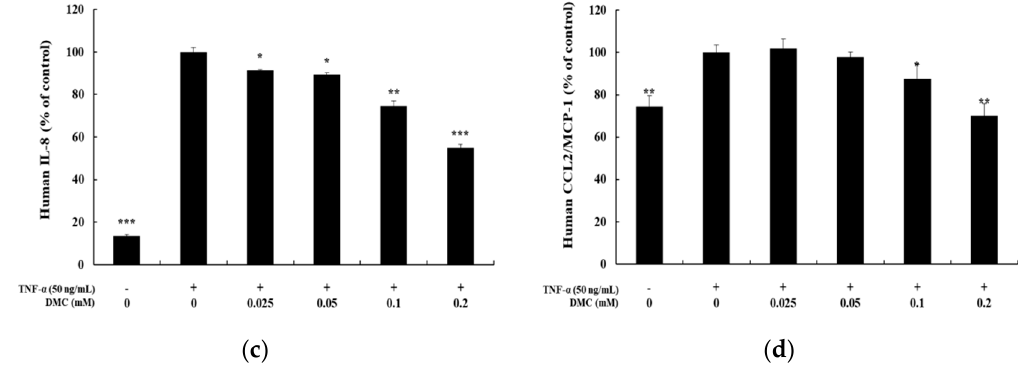
Figure 2. Effects of DMC on the pro-inflammatory cytokine production and viability of tumor necrosis factor (TNF)- α -treated HaCaT cells. The cells were treated with DMC (0.025, 0.05, 0.1, and 0.2 mM) and TNF- α (50 ng/mL) for 20 h. TNF- α -treated cells were used as a positive control. ( a ) Cell viability was determined by 3-(4,5-dimethylthiazol-2-yl)-2,5-diphenyltetrazolium bromide (MTT) assay. ( b ); ( c ); and ( d ) production of IL-6, IL-8, and CCL2/MCP-1, were measured using the culture supernatant of HaCaT cells treated as mentioned above by ELISA. The results are expressed as percentage values compared to that of the control cells. Data are presented as mean ± SD (n = 4). * p < 0.05, ** p < 0.01, and *** p < 0.001 vs. non treated control or TNF- α - treated control.